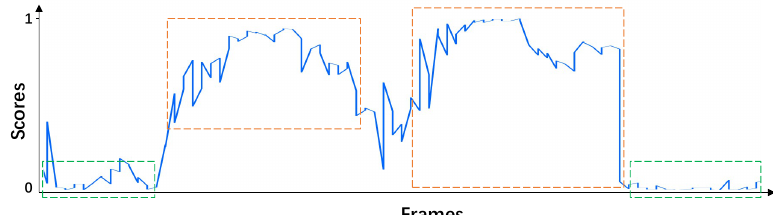
Figure 2. Example video action score curve output by the action estimation